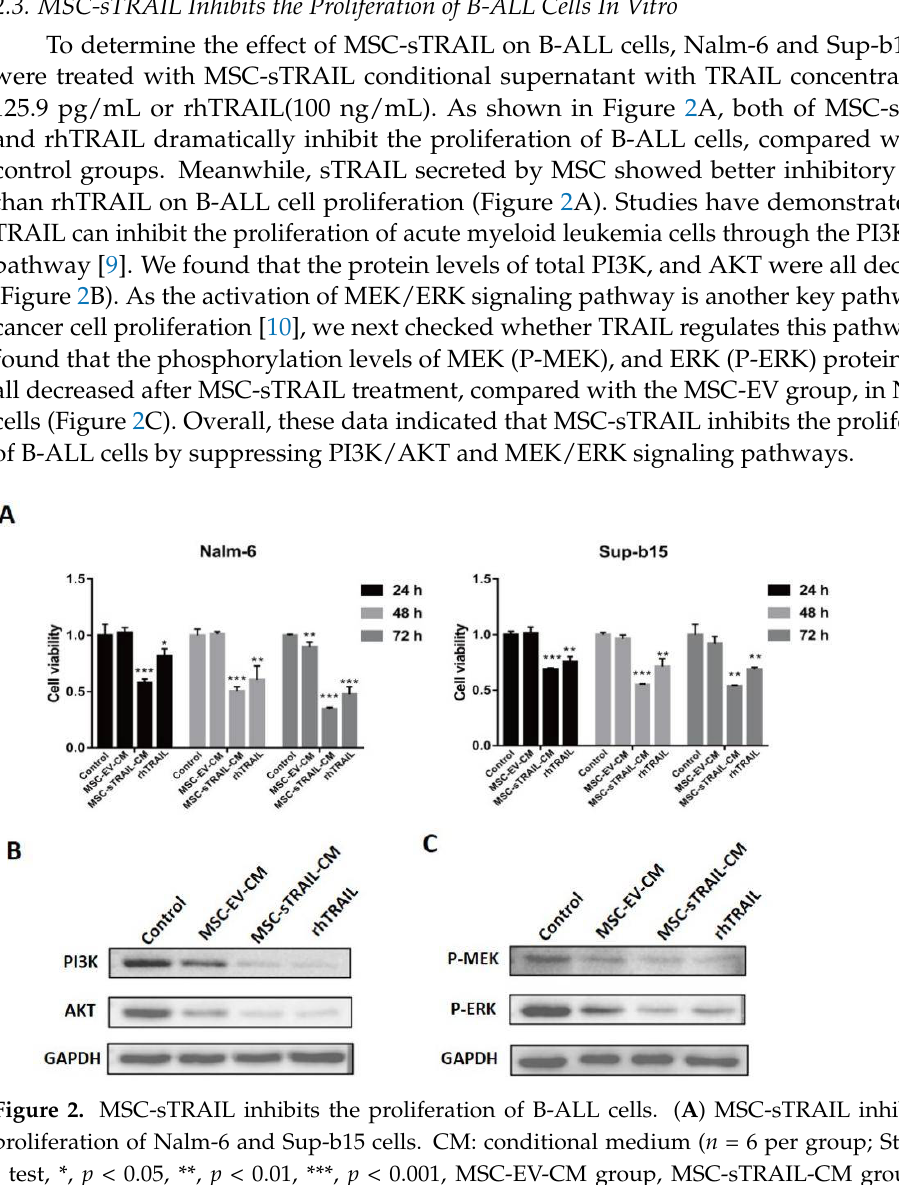
(9.82% vs. 30.28% and 23.7%, respectively, p < 0.001) (Figure 3B). Next, we investigated the mechanism of how MSC-sTRAIL or rhTRAIL induce the apoptosis of B-ALL cells. As TRAIL-induced cancer cell apoptosis could mediate by either caspase cascade pathway or mitochondria pathway [15], firstly we checked the change of cascade pathway, and we found that the levels of activation forms of apoptotic-related proteins, cleaved caspase 8, and cleaved caspase 3, were all increased in MSC-sTRAIL- or rhTRAIL- treated Nalm-6 cells, compared with control or MSC-EV group (Figure 3C). Next, we checked the protein levels of the mitochondria-related apoptotic pathway. Bcl-2 is an anti-apoptotic protein, and its expression could be suppressed by protein P53, and the decrease in Bcl-2/Bax ratio is a marker of mitochondria-mediated apoptosis [15]. We found that, after MSC-sTRAIL or rhTRAIL treated, the protein levels of P53 of Nalm-6 cells were increased, while the protein levels of Bcl-2 were decreased, accompanied by the decrease in Bcl-2/Bax ratio ( p < 0.05, Figure 3D). Meanwhile, the activation form of caspase 9, cleaved caspase 9, and its downstream target- cleaved PARP protein- levels were in- creased in MSC-sTRAIL- or rhTRAIL-treated Nalm-6 cells, compared with control or MSC-EV group (Figure 3E). Overall, these results indicated that MSC-sTRAIL induces apoptosis of B-ALL cells in vitro by both extrinsic and intrinsic apoptosis pathways (Fig- ure 3F).